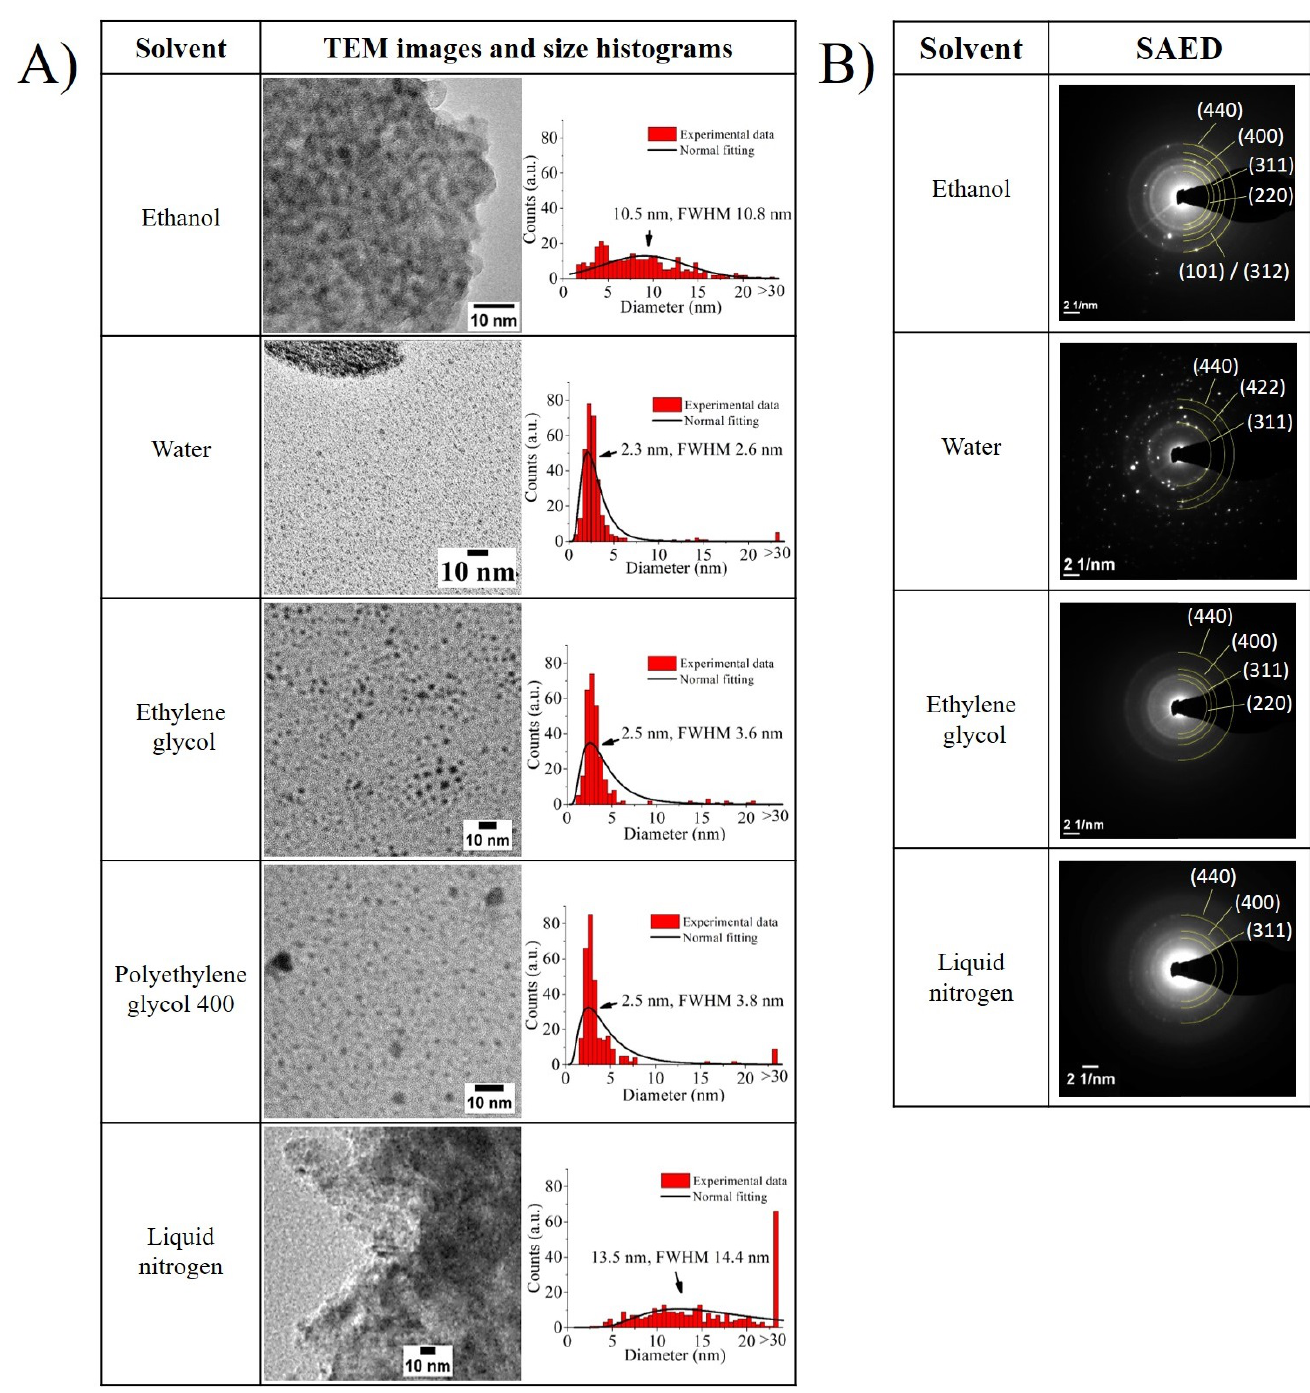
Figure 3. ( A ) Representative TEM images and size histogram of the different samples (obtained by counting 300 particles per each sample). The average size calculated from the normal fitting is indicated in the histograms. ( B ) SAED images of all samples (aside from polyethylene glycol 400). The d-spacings were assigned to the crystallographic families indicated in the Table S1 in the Supplementary